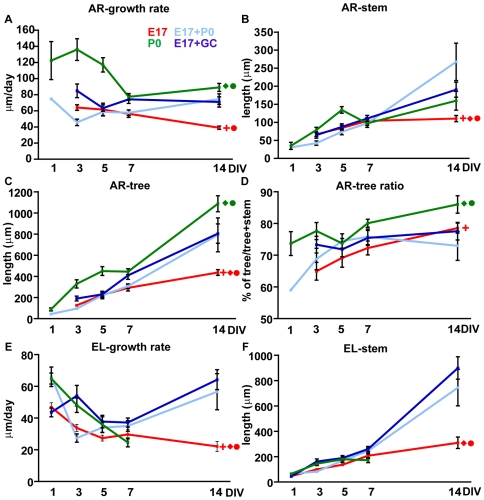
Morphometric parameters of Purkinje axons in pure embryonic (E17) or postnatal (P0) cultures and in co-cultures of embryonic cells with postnatal cells (E17+P0) or with granule cells (E17+GC).(A–D) Parameters of AR axons. (A) P0 and GC environments have a different effect on the growth rate of 17 AR cells (E17+P0: two way ANOVA, P = 0.40; E17+GR: two way ANOVA, P<0.001). However, (B) both culture conditions promote the elongation of the stem compartment (two way ANOVA, always P<0.05) that reaches the value observed in P0 AR cells (two way ANOVA, always P>0.60). (C) Both culture conditions boost the extension of the terminal arbor (two way ANOVA, P≤0.002), although the values are always significantly lower than those of postnatal trees (two way ANOVA, P≤0.002). (D) Because of the concomitant growth of stem and tree compartments (see B and C), the tree ratio is not different from the values of pure E17 cultures (two way ANOVA, P>0.05). (E–F) Parameters of EL axons. (E) Both E17 and P0 environment promote the growth rate of embryonic axons, up to the values typical of their postnatal counterparts (E17+P0 or E17+GC vs E17, two way ANOVA, P<0.001; E17+P0, two way ANOVA: P = 0.66; E17+GC vs P0, two way ANOVA: P = 0.10). (F) In both co-cultures, the length of the stem axon at 14 DIV is significantly longer than that observed in pure E17 cultures (two way ANOVA, P<0.001). Missing points in the plot lines are due to the absence of cells the relevant class at specific culturing times. Error bars, SEM. Significant main effect of population: red cross, E17 vs P0; red diamond, E17 vs E17+P0; red circle, E17 vs E17+GC; green diamond, P0 vs E17+P0; green circle, P0 vs E17+GC.